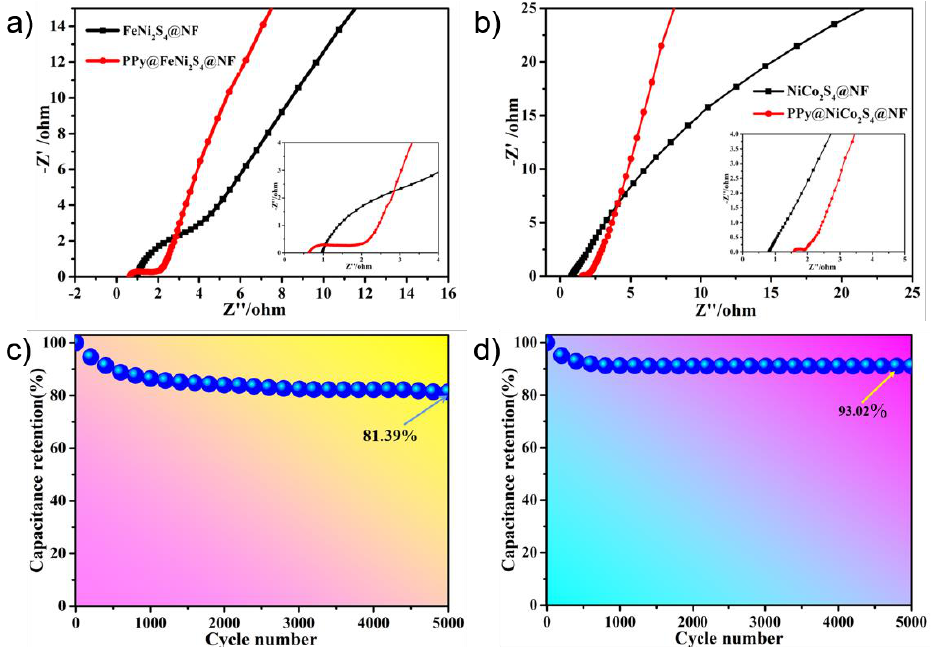
Figure 5. ( a ) Nyquist plots of PPy@FeNi 2 S 4 @NF and FeNi 2 S 4 @NF electrodes. ( b ) Nyquist plots